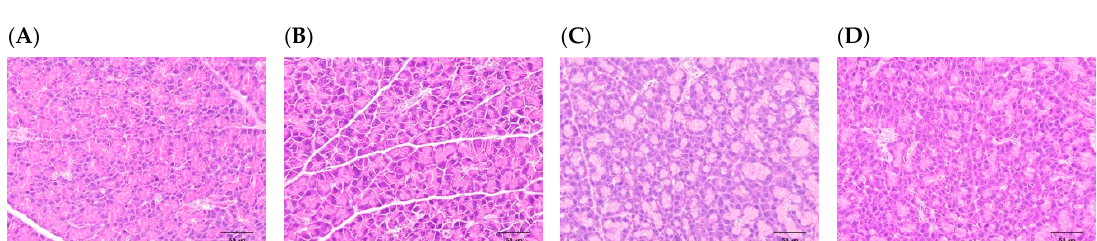
Figure 5. Histopathological changes by hemotoxylin and eosin (H & E) staining (400×) of the islets of the pancreas in rats with STZ-induced β -cell toxicity. ( A ) Sham control. Normal architecture of the β - cells in the islets of the pancreas. STZ induced a slight to moderate/severe decrease of β -cells in the islets of the pancreas in ( B ) T2DM control model. ( C ) T2DM model treated with HC for 28 days. ( D ) T2DM model treated with SO for 28 days. Scale bar = 50 μ m.